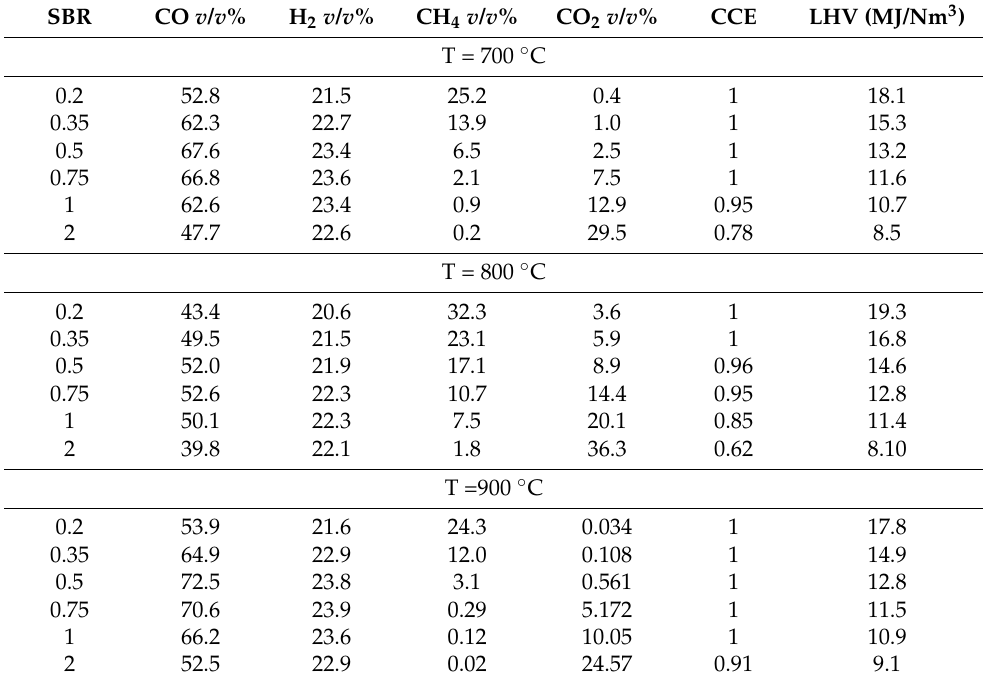
Table 8. Effect of steam-to-biomass ratio (SBR) and gasification temperature on the syngas composi- tion simulated results (SRes) by Aspen Plus.